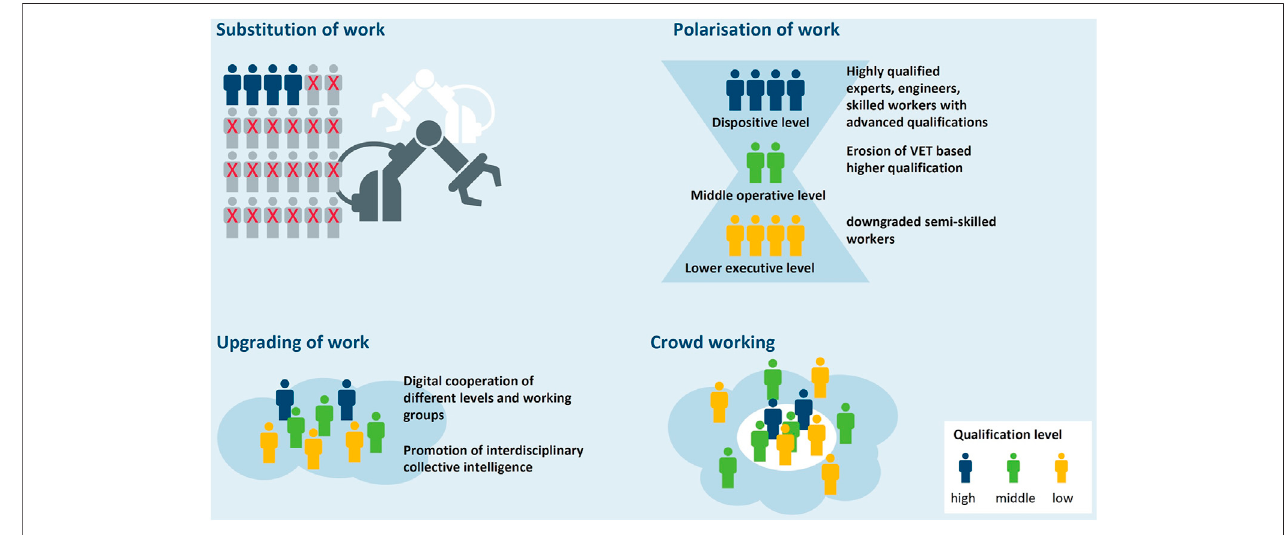
FIGURE 1 | Scenarios of the impact of industry 4.0 on work (Abel et al., 2019, own translation, permission